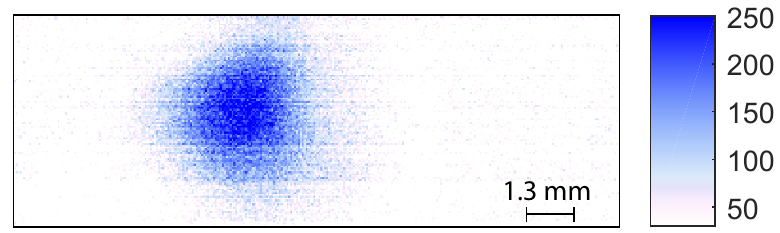
Figure 6: Blue photons collected from 1 × 10 8 atoms during an exposure time of 20.5 ms. The image is an average of 10 individual images. Each image is the difference of an image taken when the polarizer is on and a background image with the polar- izer off. Pixel strength denotes fluorescence intensity. The polarizer intensity is 2.9 mW / cm 2 corresponding to 115 µ W of